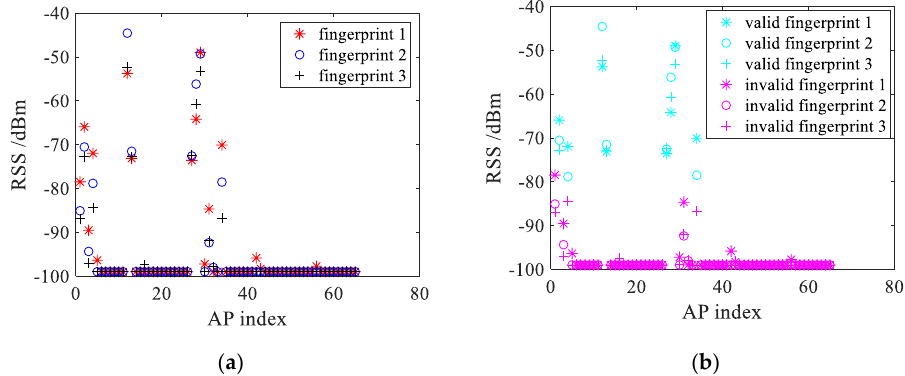
Figure 4. Distribution of RSS: ( a ) at different reference points, ( b ) at valid and invalid reference points.